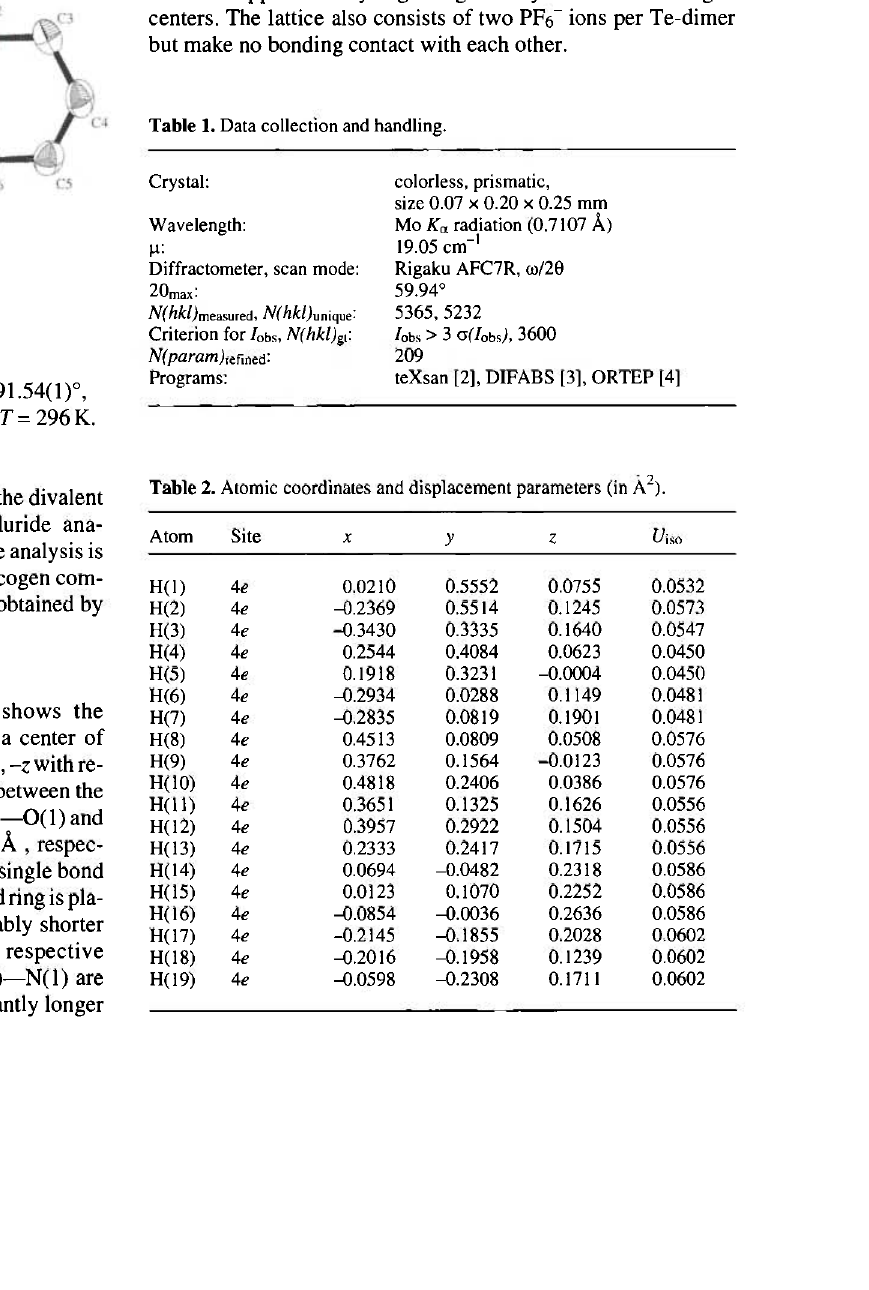
Table 1. Data collection and handling.